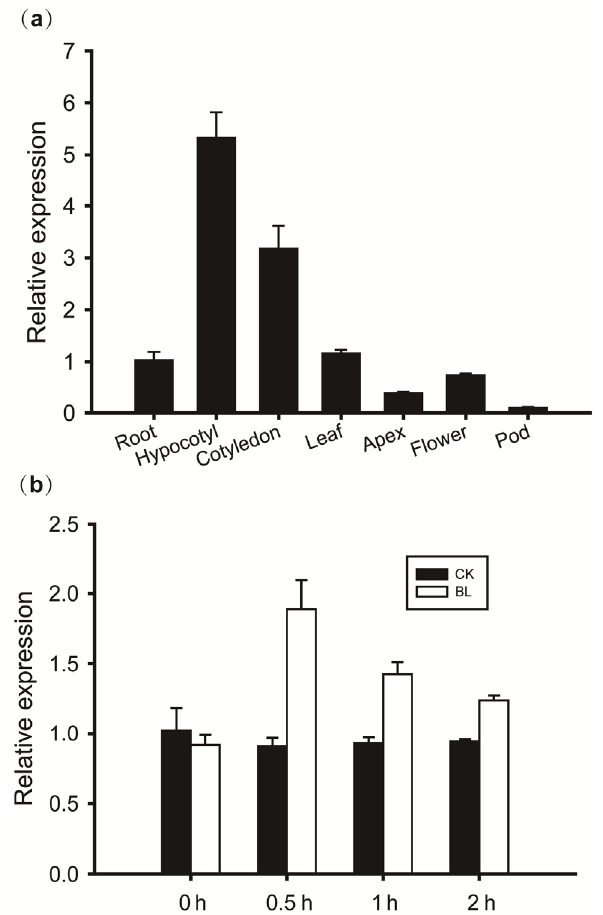
Figure 7. ( a ) qRT-PCR analysis of GmBRI1 mRNA in different tissues of soybean cv. Williams 82 . The sampling time of each tissue is described in Section 4.3. The relative expression levels are normalized to GmELF (GenBank accession No. NM_001249608). The data represent the mean ± SE of three independent experiments; and ( b ) The inducible expression of GmBRI1 in the leaves of Williams 82 under BR treatment. CK, untreated group (black column); BR, treated group (white column). The x -axis represents the time of the treatment: 0 h (before treatment), 0.5 h (treated for 0.5 h), 1 h (treated for 1 h) and 2 h (treated for 2 h). The relative expression levels are normalized to GmG6PDH (GenBank accession No. XM_003547631). The data represent the mean ± SE of three independent